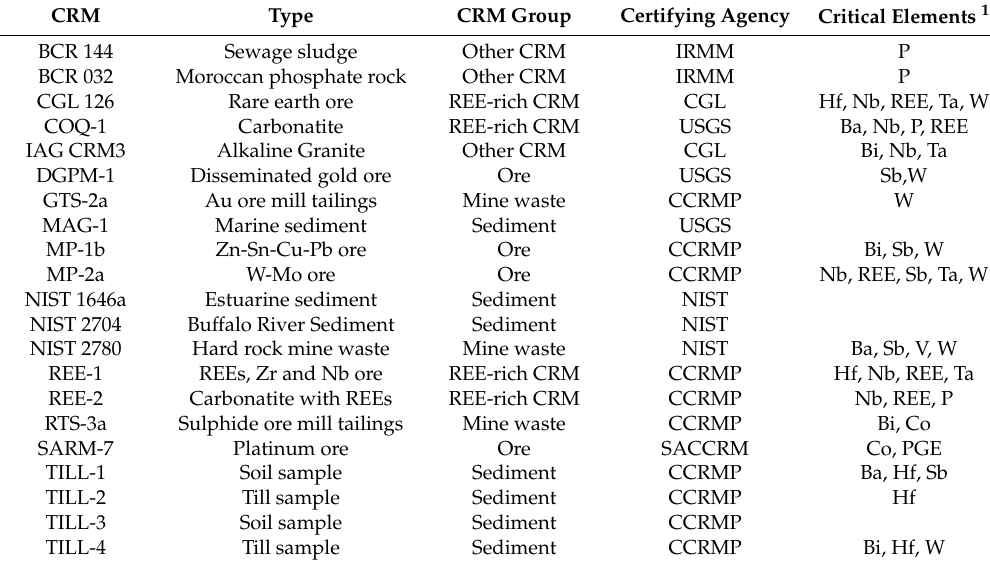
Table 1. Certified reference materials (CRM) used in this